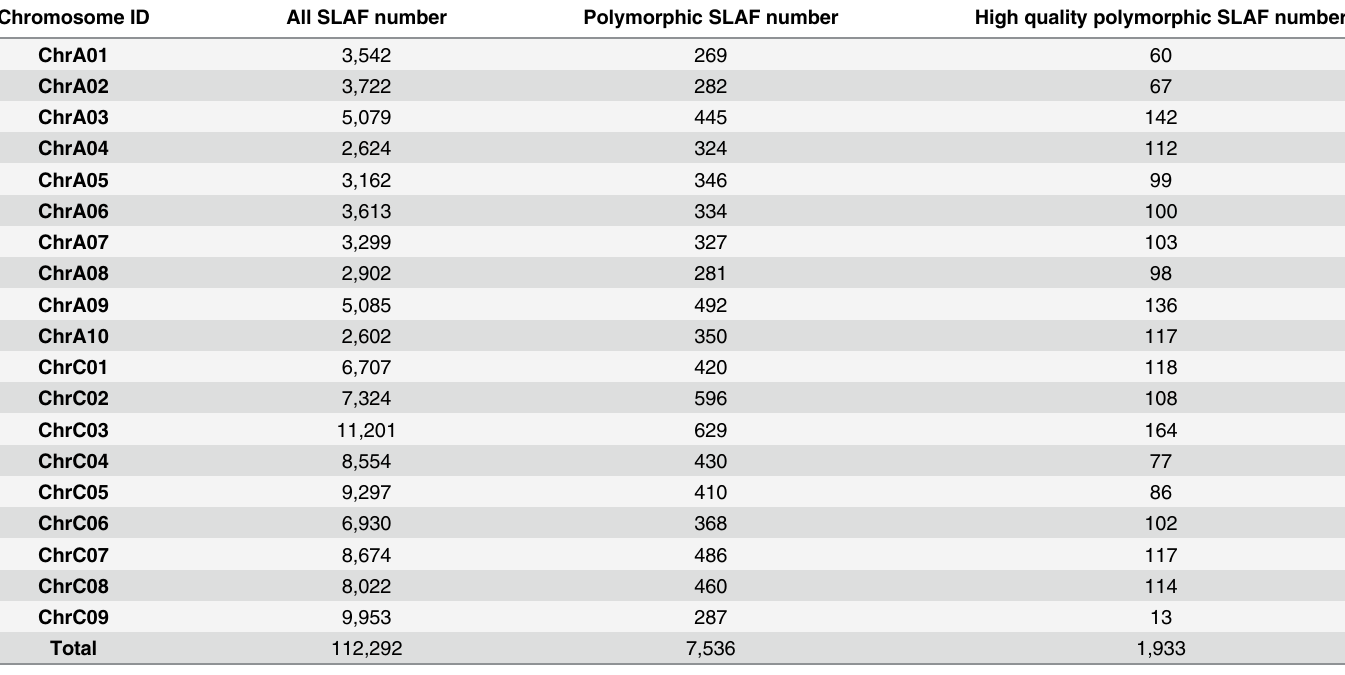
Table 4. Number of all SLAFs, polymorphic SLAFs and high quality polymorphic SLAF number on each